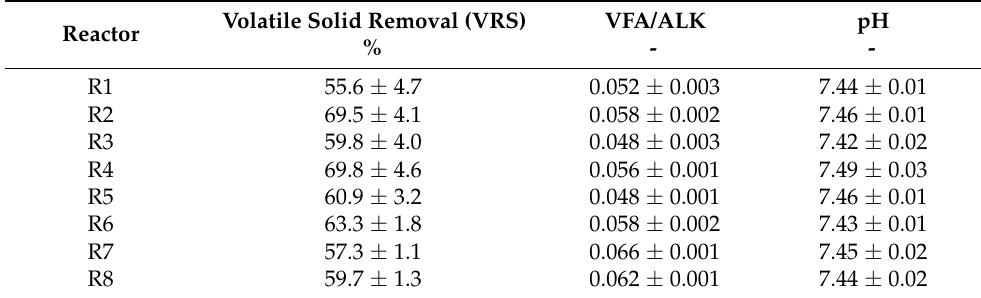
Table 2. Results of volatile solid removal (VRS) and stability parameters in the corresponding series (average values and standard deviations are